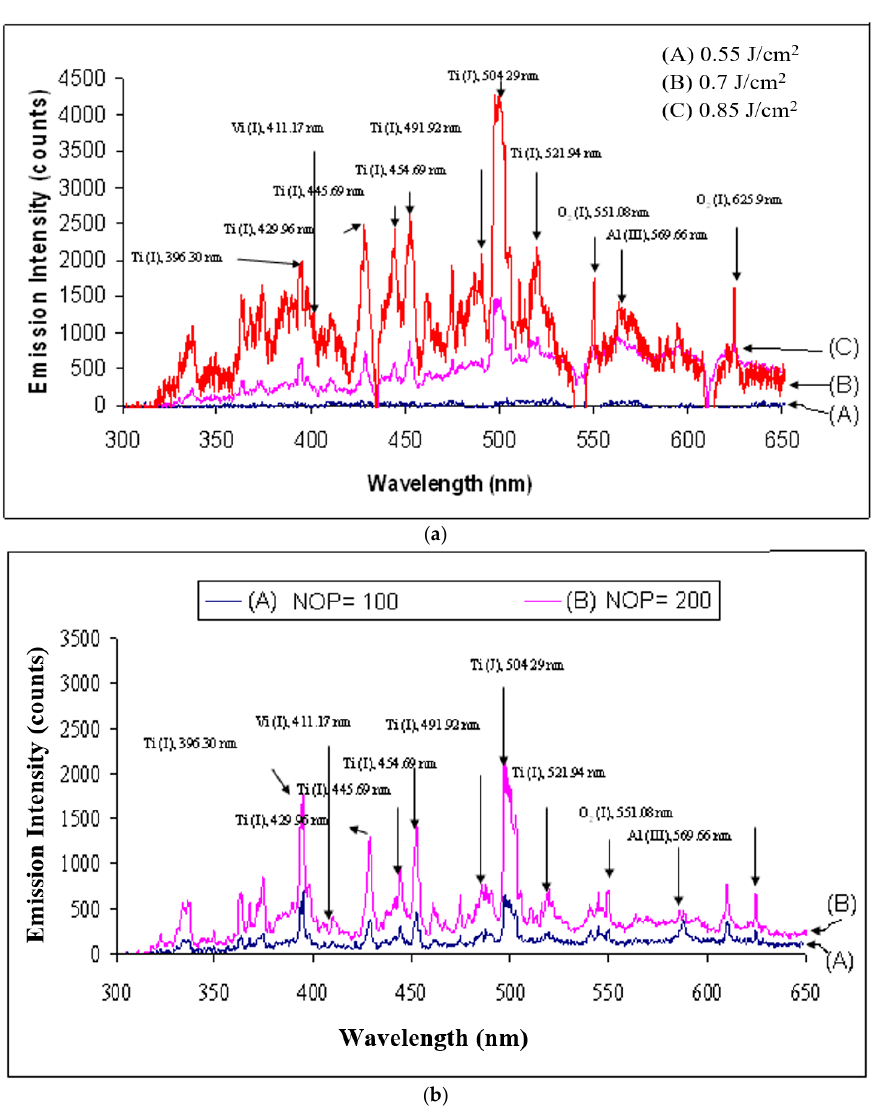
Figure 8. Emission spectra of titanium alloys for various laser fluences ( a ) Stationary beam (after 200 pulses, beam size = 1 mm 2 ), ( b ) Moving beam (fluence = 0.85 J/cm 2 , beam size 1 mm 2 , lens focal length = 200 mm).